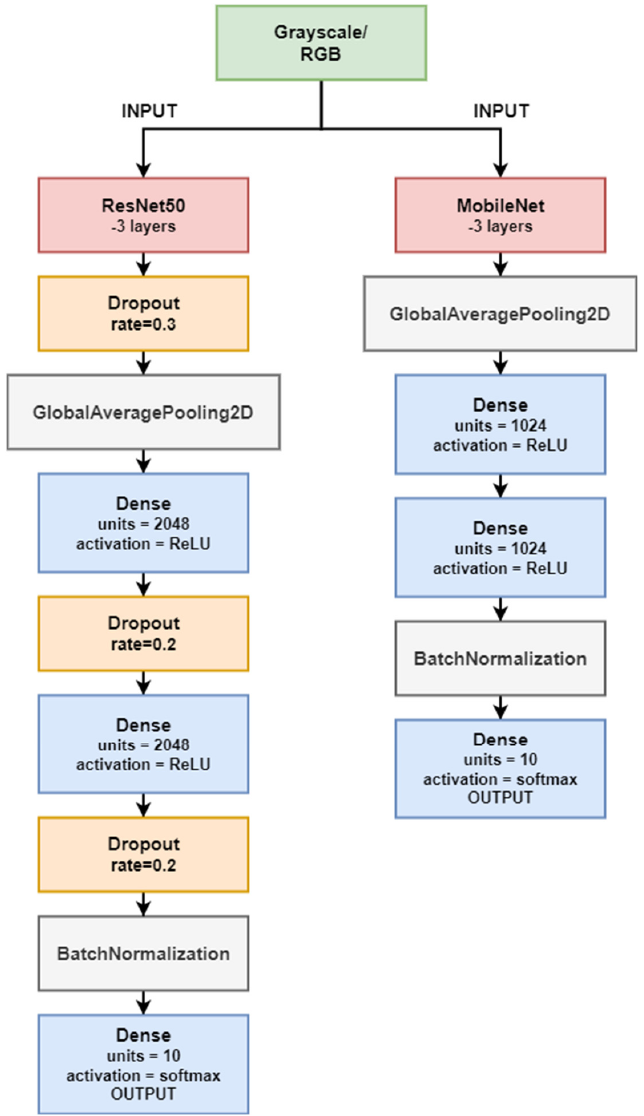
Figure 16. Resnet50 and MobileNet structure. Top blocks representing frozen layers—3; the rest are 3 layers replaced for transfer learning.